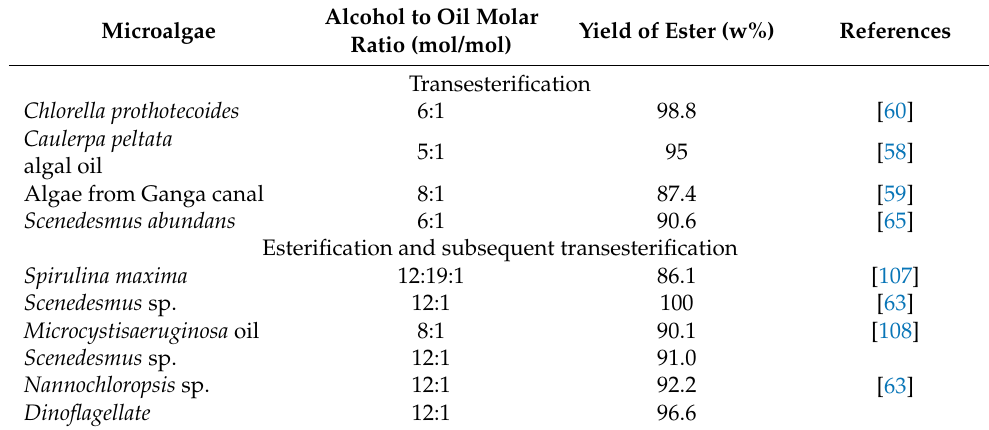
Table 9. Molar ratio of alcohol to oil and yield of esters